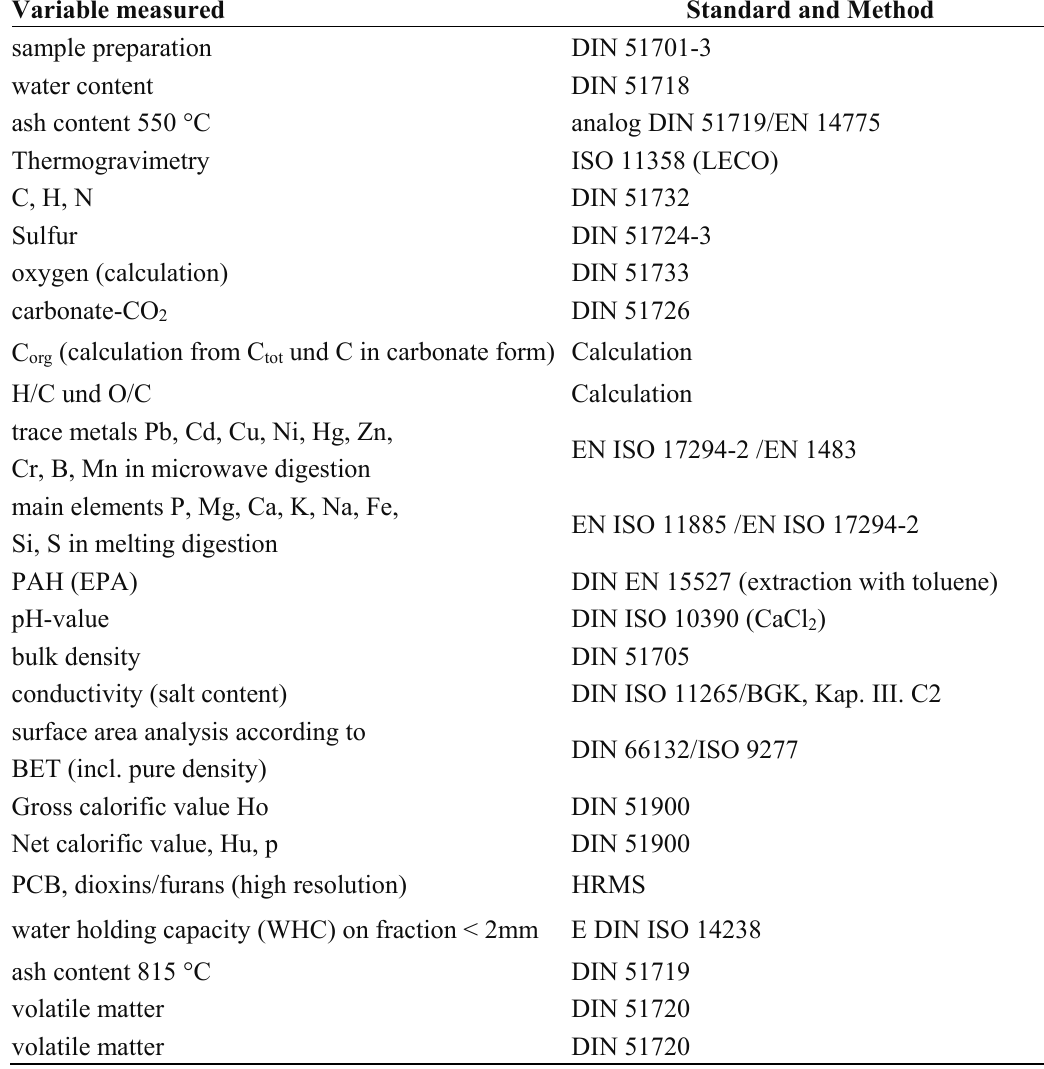
Table 3. Parameter package